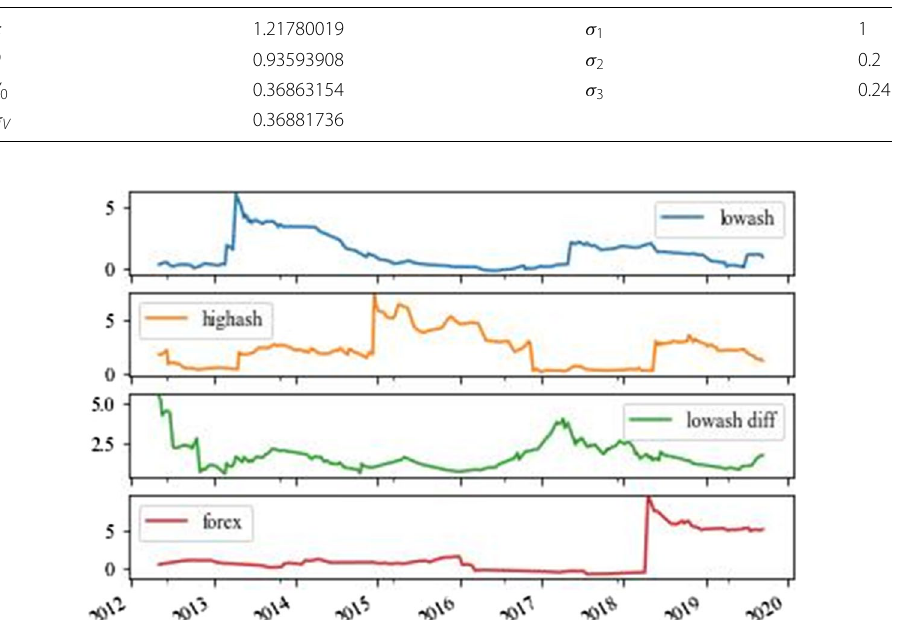
Table 1 Model parameters